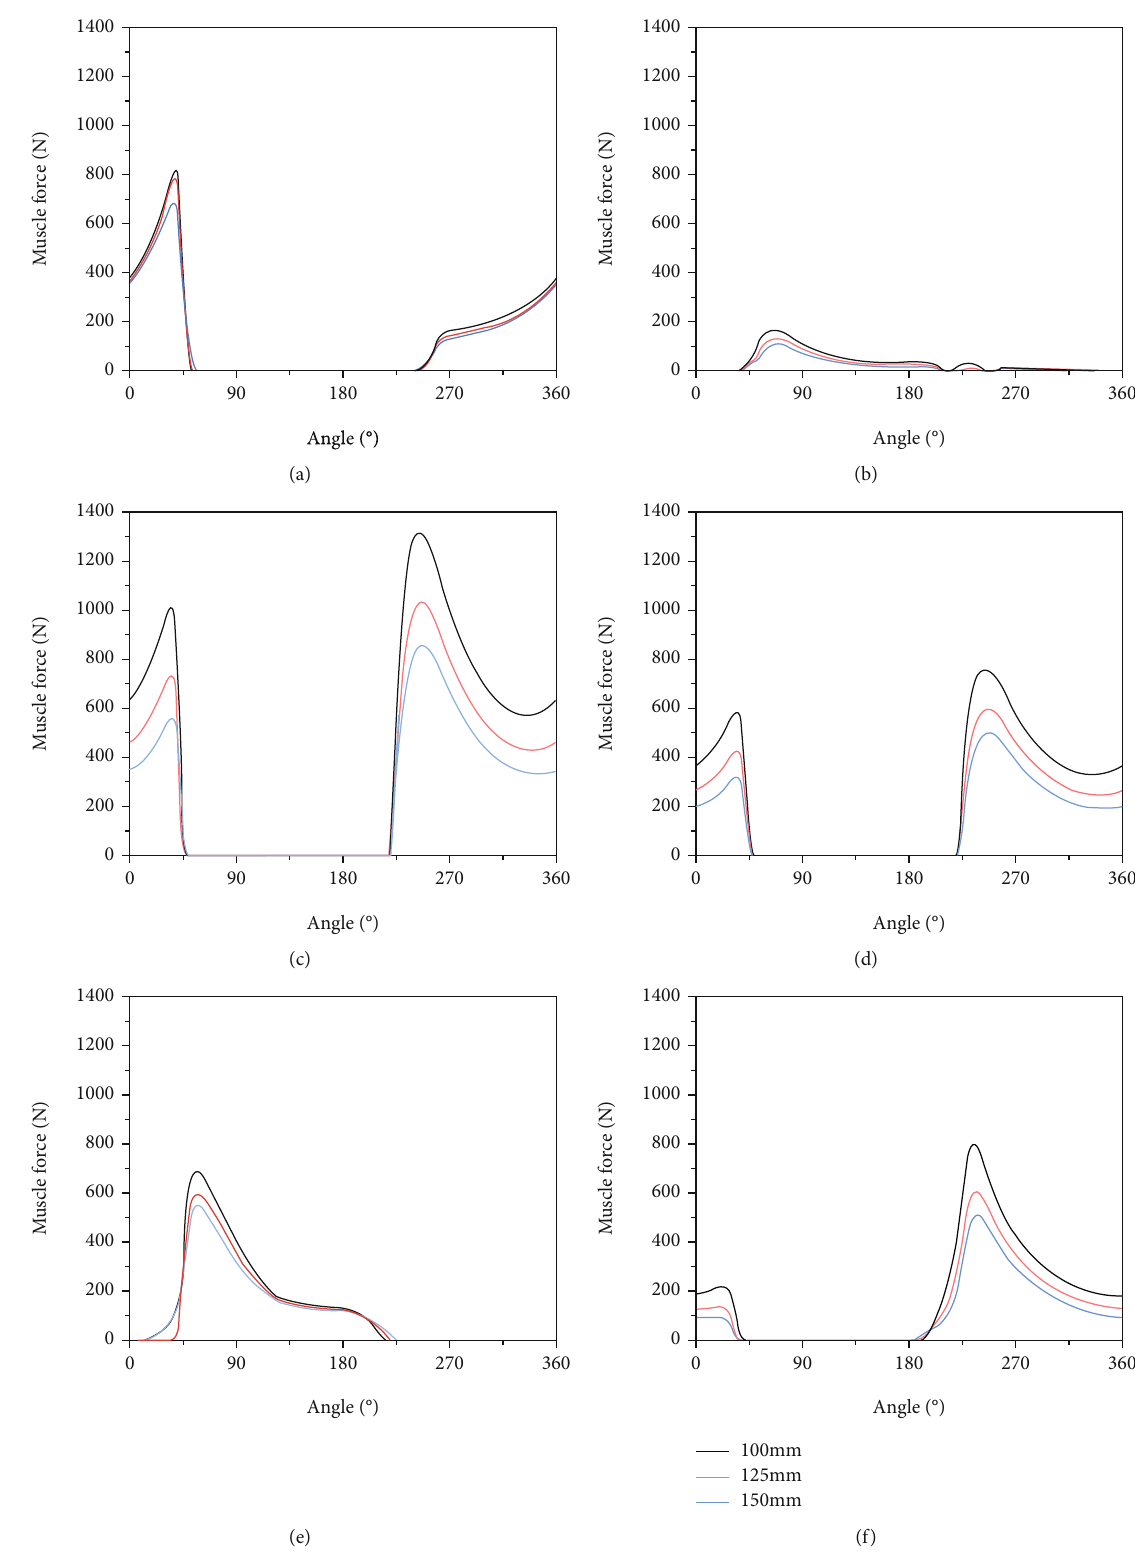
Figure 5: The muscle force of six muscles during a cycle (0-360 ° ) in the di ff erent crank lengths: (a) SOL, (b) TA, (c) VL, (d) VM, (e) GAS, and (f)